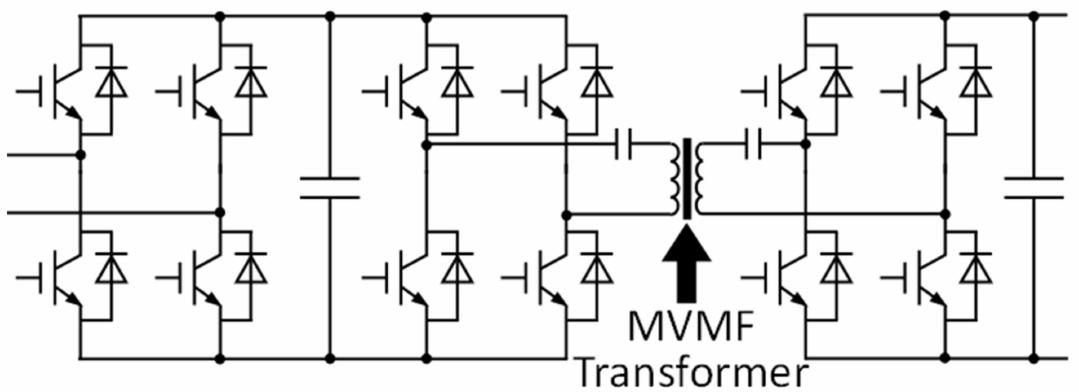
Figure 1. A typical topology with a medium voltage medium frequency